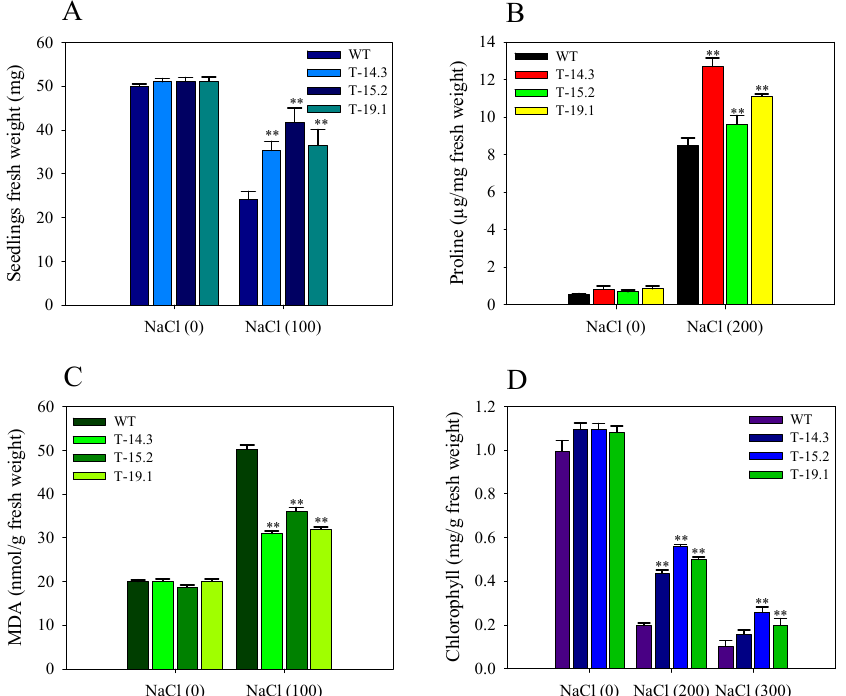
Figure 13. Seedling biomass of AnnAt8 transgenic tobacco plants under salt stress and measurement of chlorophyll, malondialdehyde (MDA) and proline content under salt stress. ( A ) Fresh weight of transgenic and WT seedlings after nine weeks of growth on half strength MS (with 0 and 100 mM NaCl). For seedling weight average, 10 seedlings for each biological replicate (n) were used; ( B ) Proline content of transgenic and WT seedlings with (200 mM NaCl) and without salt treatment; ( C ) MDA content of transgenic and WT seedlings with (100 mM NaCl) and without salt treatment ( D ) Total chlorophyll content of leaf discs from WT and transgenic tobacco plants with and without NaCl treatment. The data represent the means of n = 3 ± SE. Two asterisks indicate that the mean values of transgenic lines were significantly higher than that of WT when analyzed by one-way ANOVA ( p < 0.01).